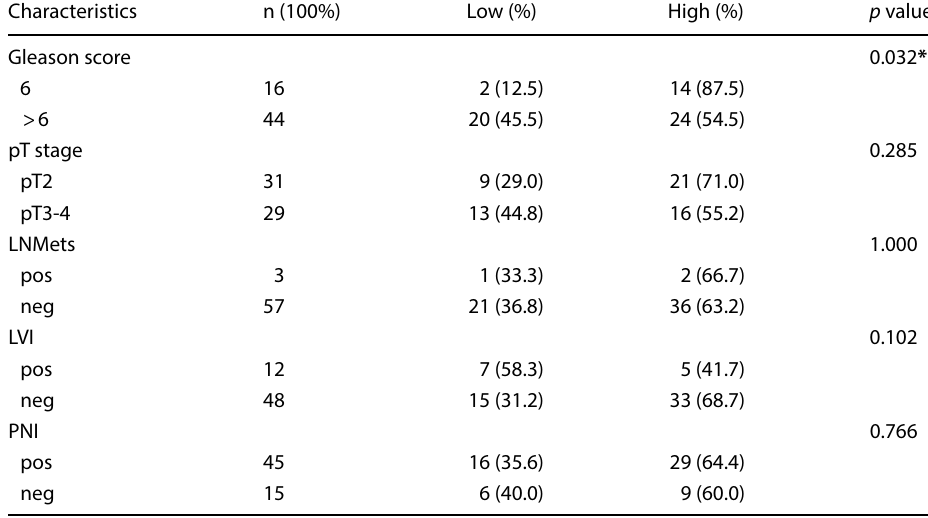
Table 2 Expression of CIP2A expression and clinicopathological parameters in PCa